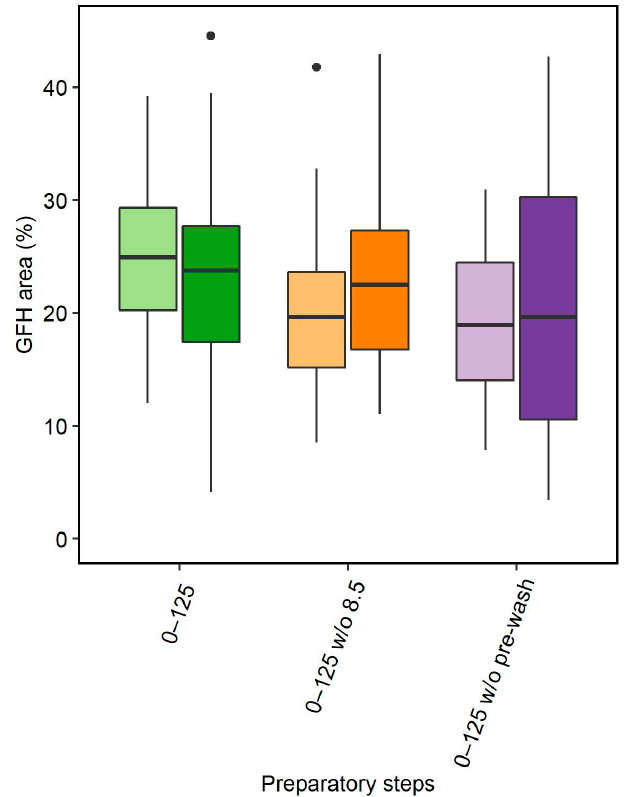
Figure 5. Influence of preparatory steps on area covered by µ GFH; same colors indicate duplicate columns.